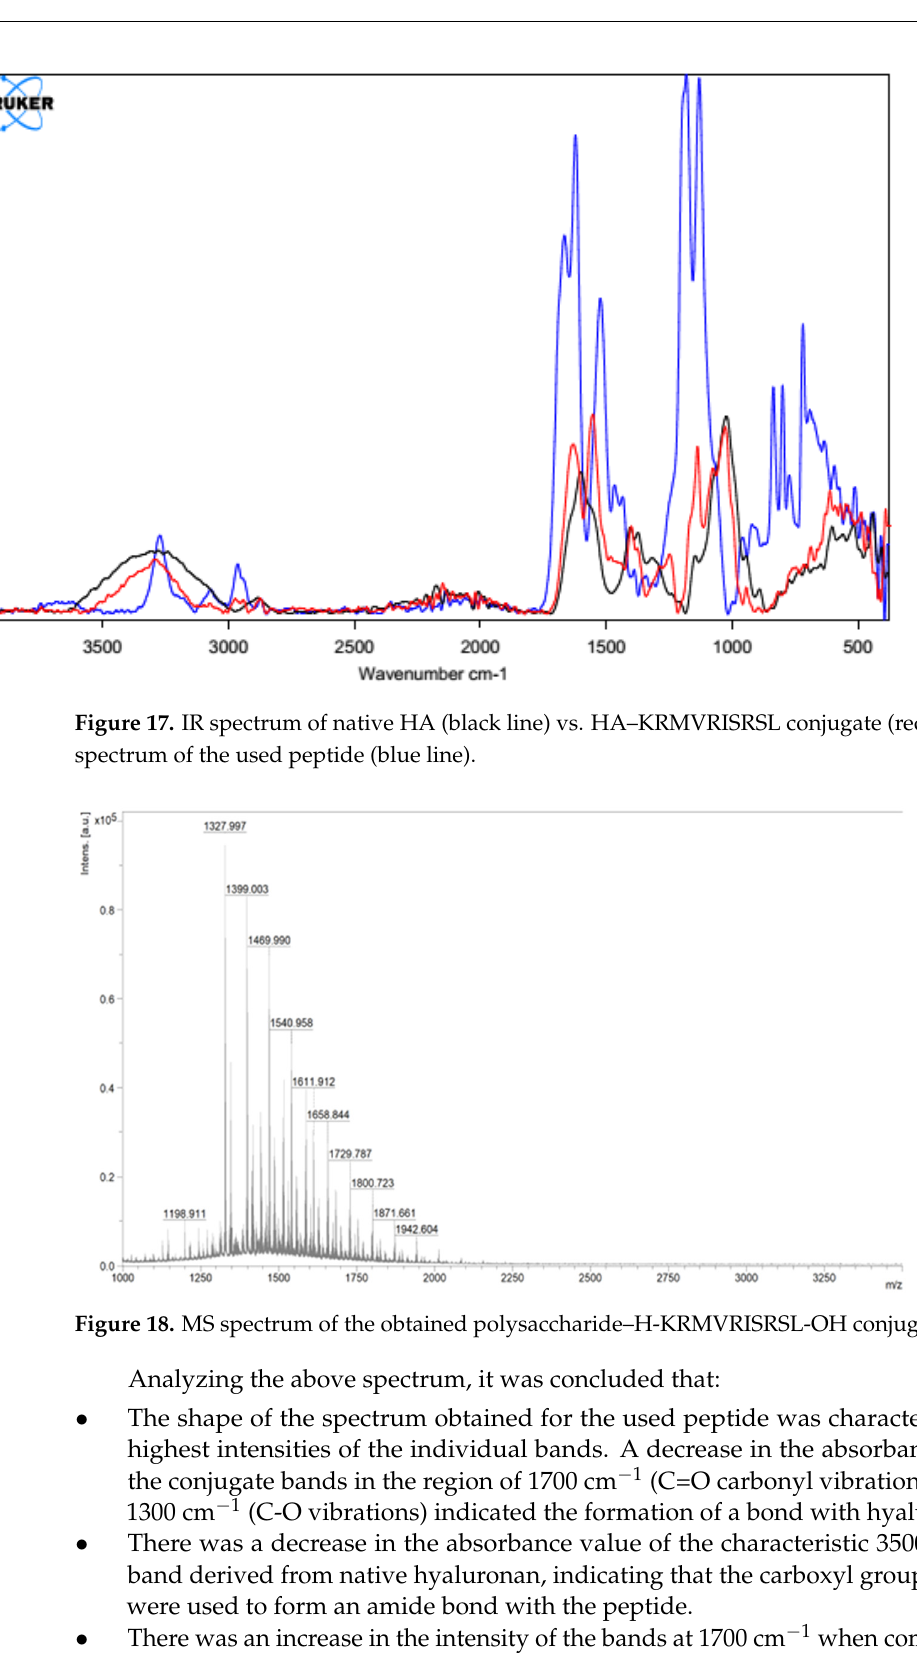
Table 1. Analysis of the characteristic peaks from the MS spectrum of the obtained polysaccharide– H-KRMVRISRSL-OH